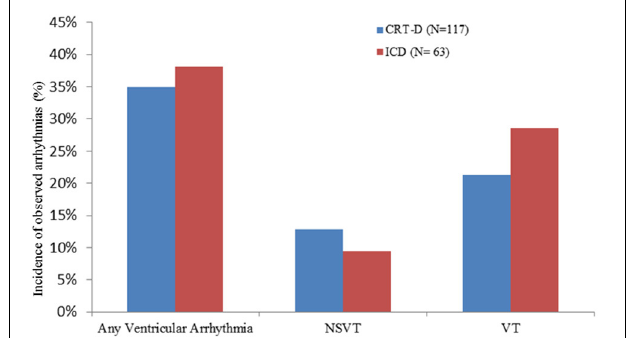
FIGURE 2 | Incidence of tachy-arrhythmias in the CRT-D and ICD